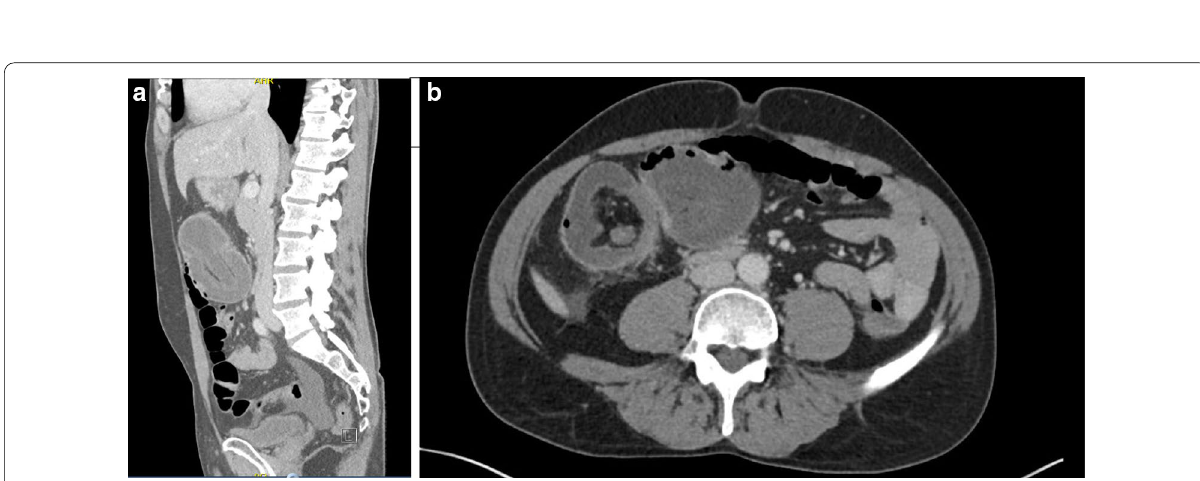
Fig. 2 Commuted tomographic abdominal pelvic imaging of a sagittal, and b coronal planes demonstrating ileocaecal intussusception at